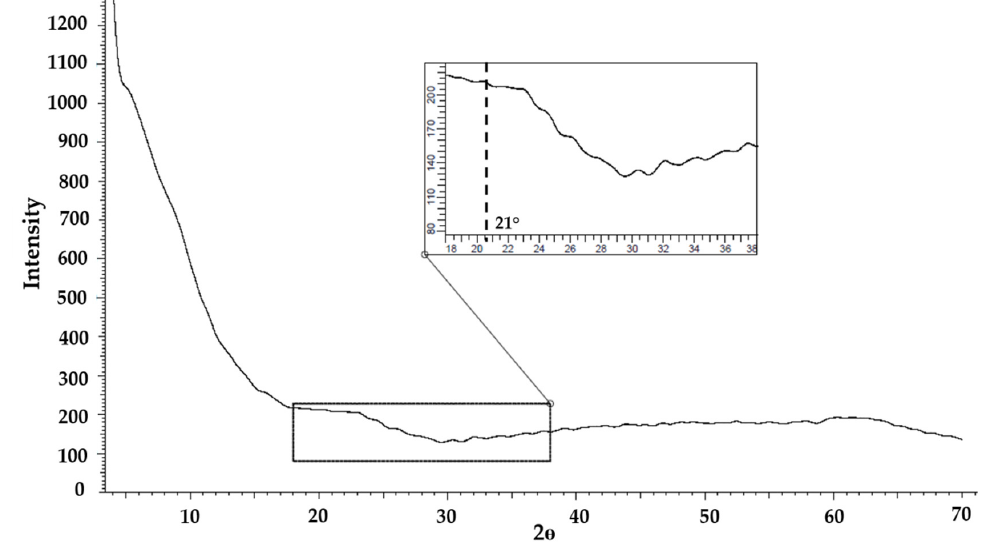
Figure 7. Di ff ractogram of nSiO 2 -APTES Figure 7. Diffractogram of nSiO 2 -APTES NPs. Figure 7. Diffractogram of nSiO 2 -APTES NPs.